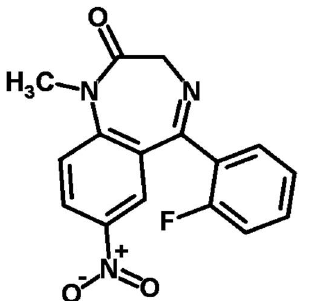
FIGURE 1 – Fluorine molecule of flunitrazepam. Source: www.rsc.org